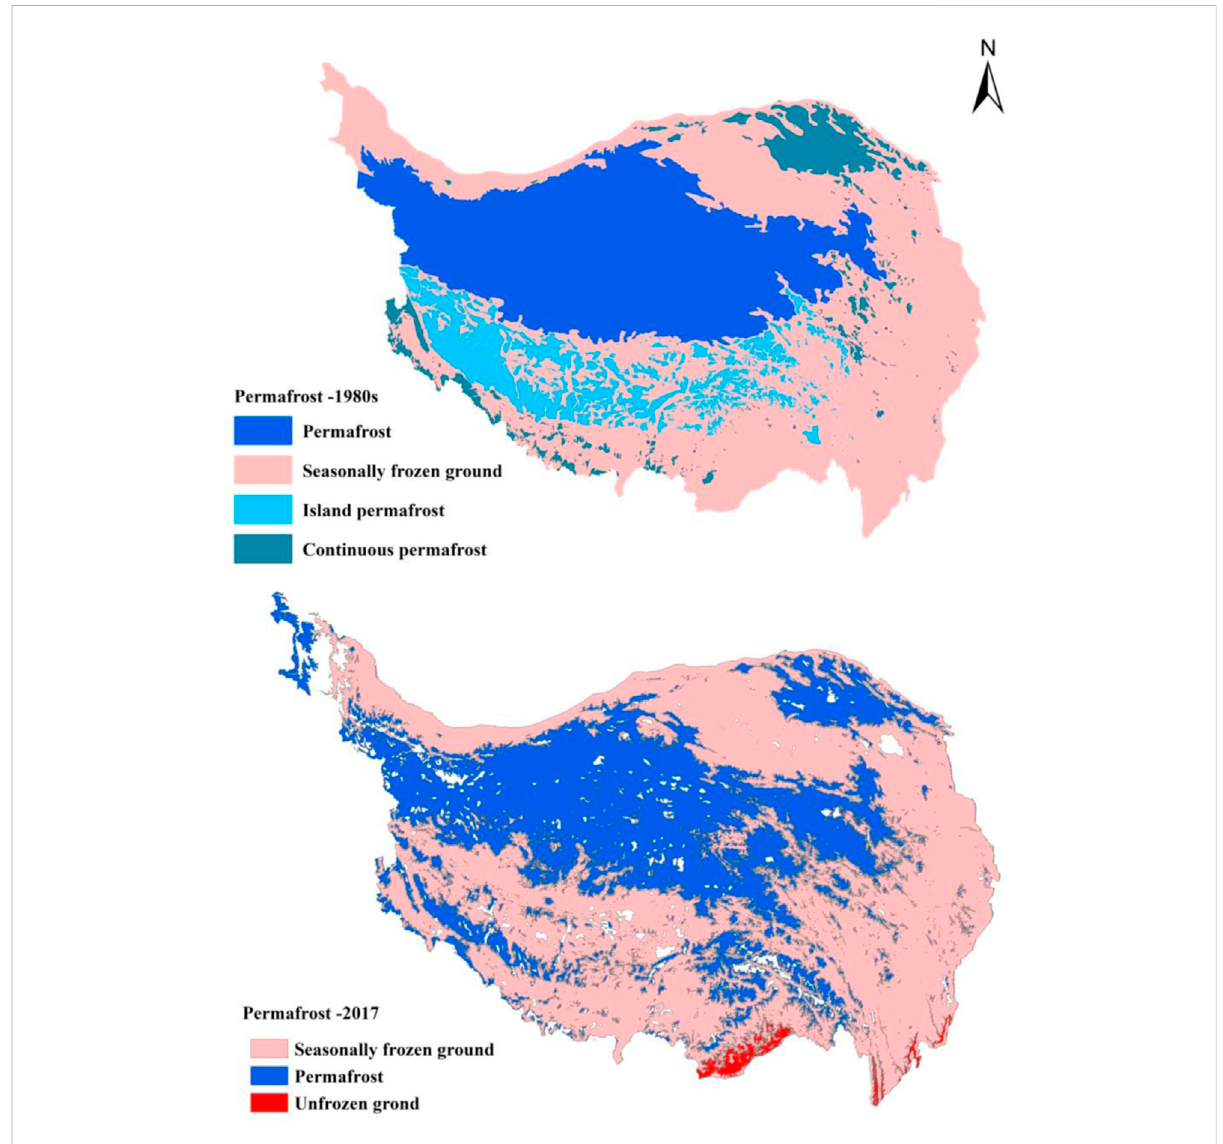
FIGURE 7 Permafrost change of the QTP from the 1980s to